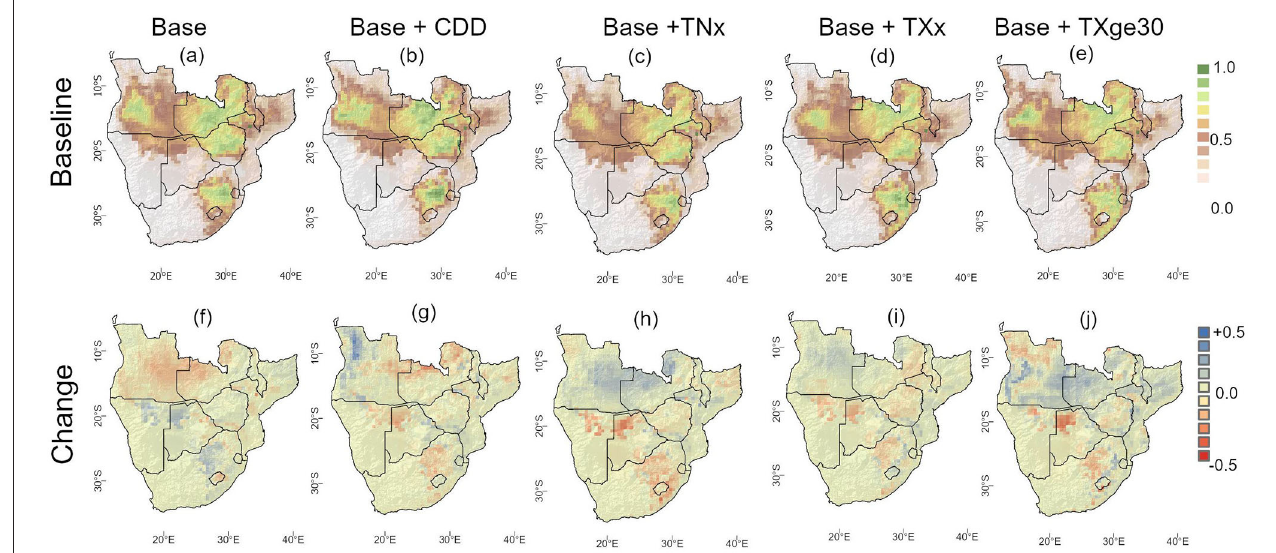
FIGURE 4 | Maps showing maize suitability under baseline (1986–2014) and future changes (2036–2064) in maize suitability for the base model (first column), and adding CDD (second column), TNx (third column), TXx (fourth column) and TXge30 (fifth column) indices to the modeling. A suitability of 1 can be interpreted as highly suitable, while 0 means not suitable. The changes (lower row) are calculated as future suitability minus baseline suitability with positive values showing improved suitability and negative values showing decreases in maize